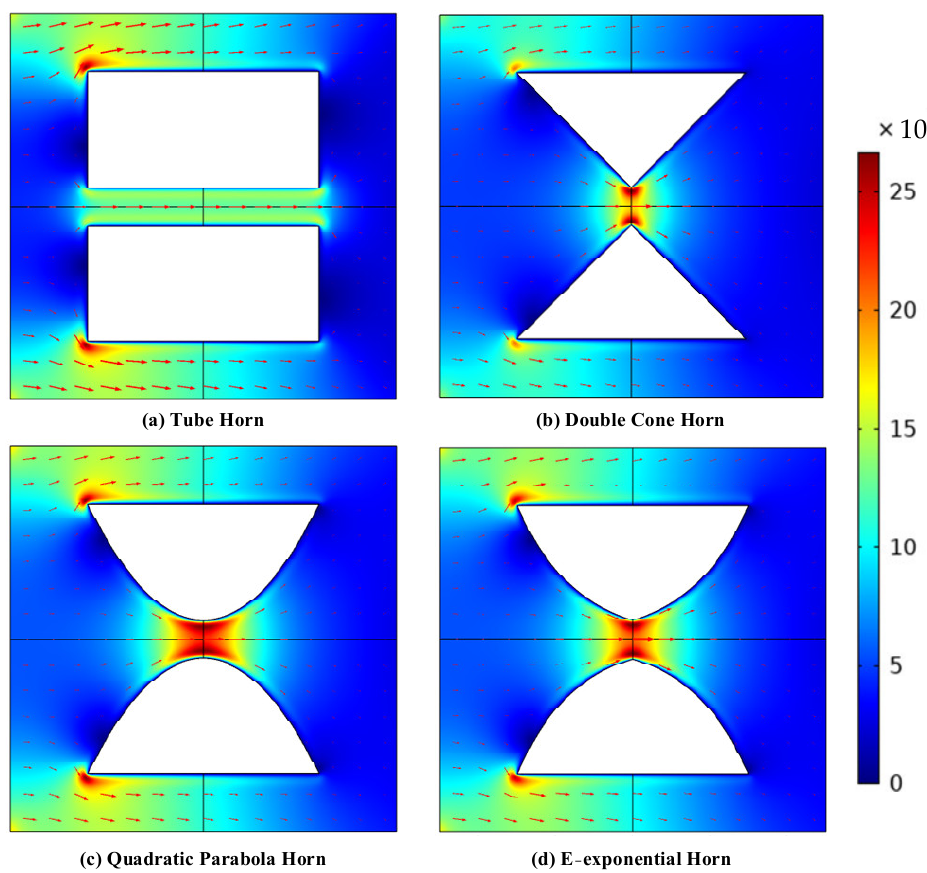
Figure 3. Acoustic particle velocity cross-sectional distribution at 500 Hz for: ( a ) tube horn; ( b ) DC horn; ( c ) DP horn; ( d ) DE horn.